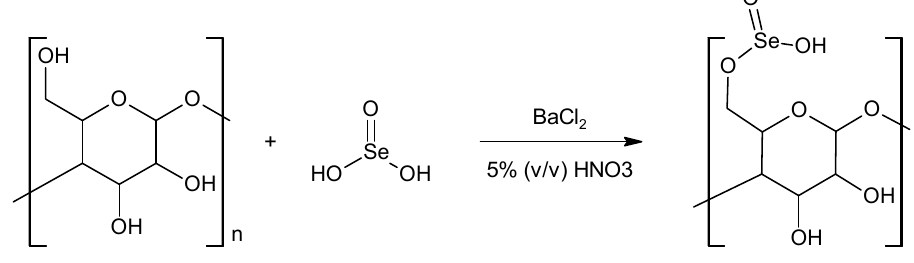
Figure 8. Formation of the selenious acid ester of carbohydrate.